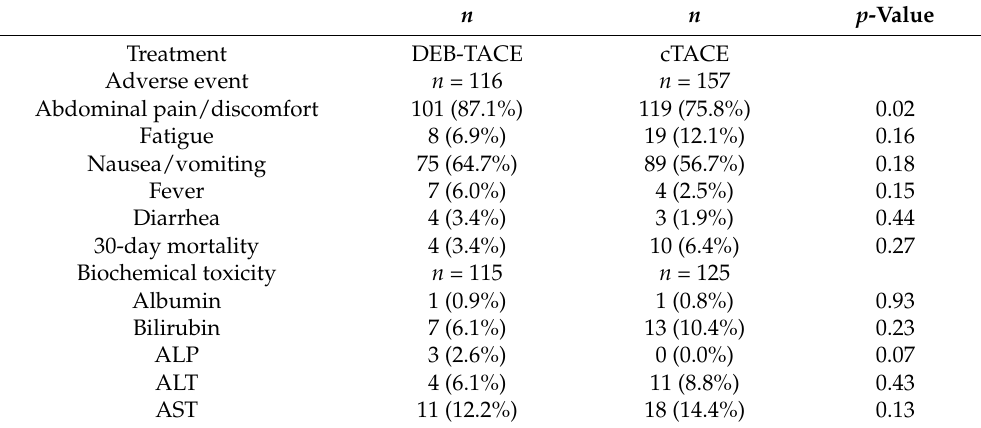
Table 4. Summary of the most prevalent grade 3 or higher adverse events according to